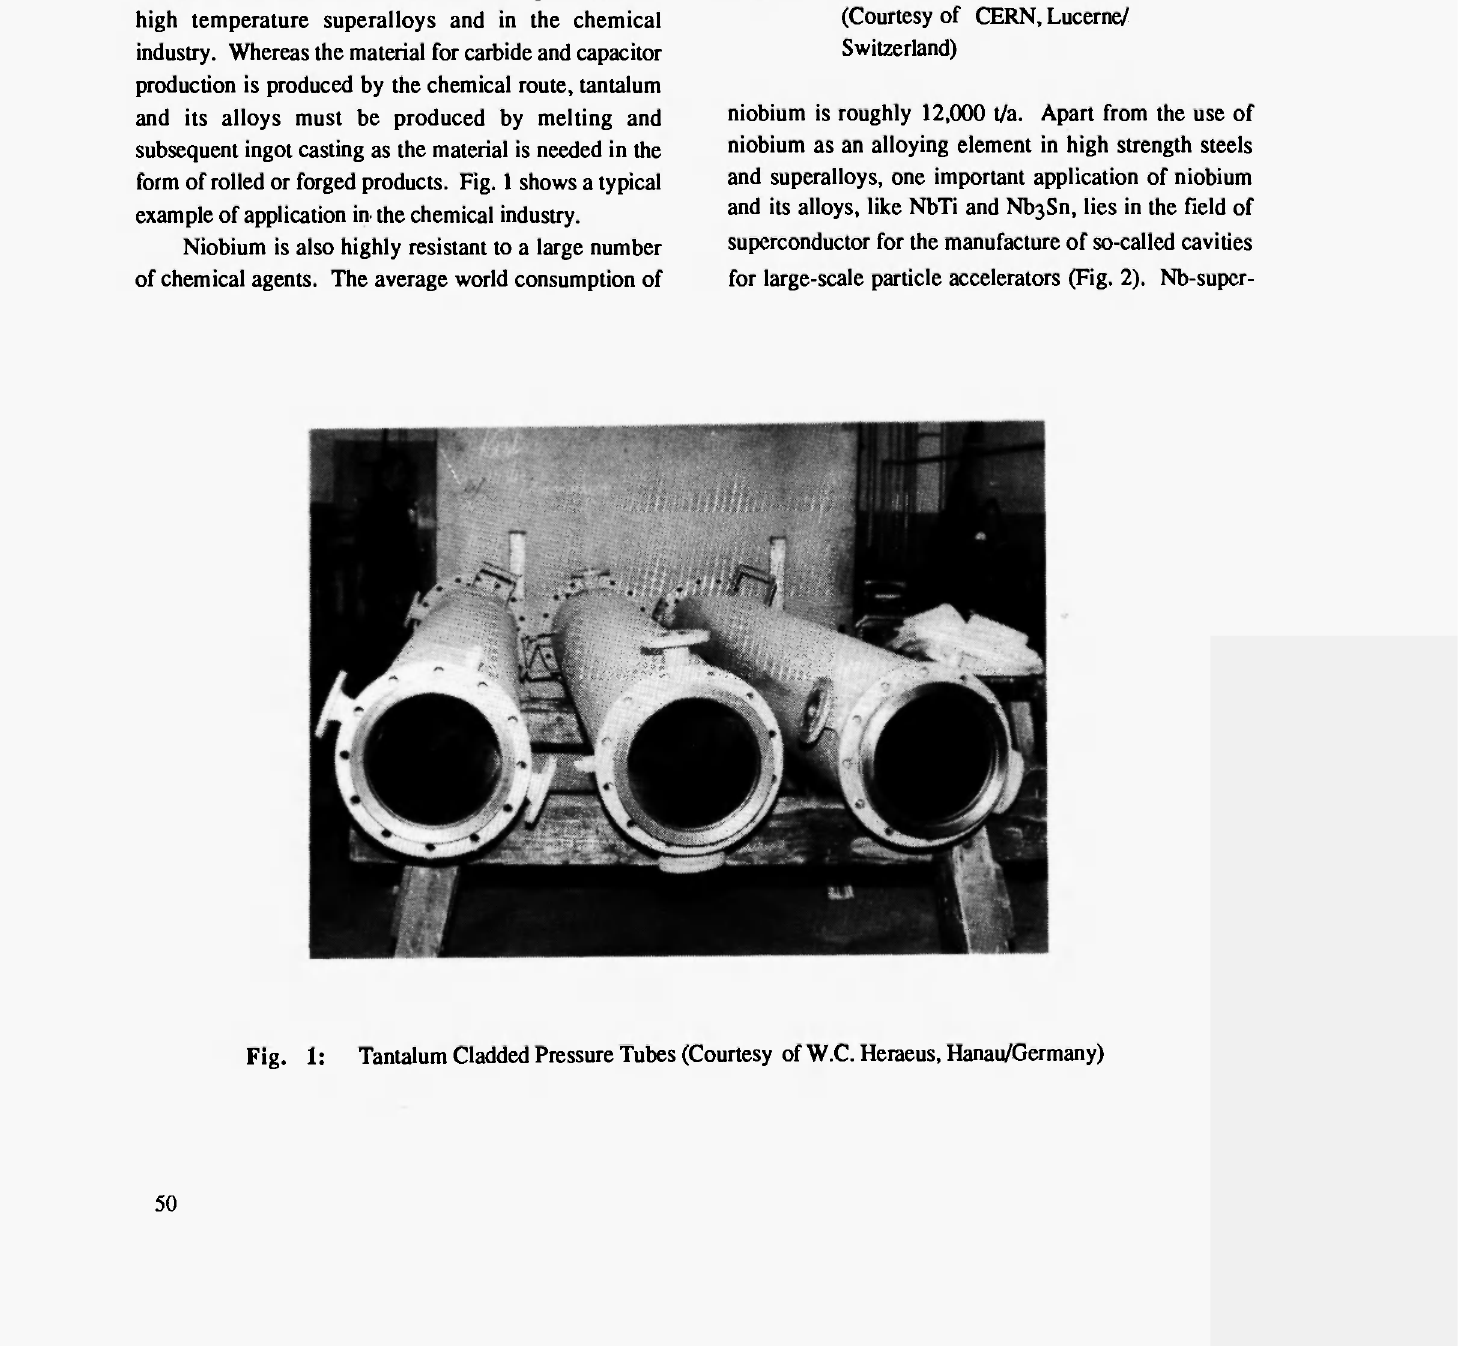
Fig. 2: Four-Cell Nb-Cavity Structure (Courtesy of CERN, Lucerne/ Switzerland) niobium is roughly 12,000 t/a. Apart from the use of niobium as an alloying element in high strength steels and superalloys, one important application of niobium and its alloys, like NbTi and Nb3Sn, lies in the field of superconductor for the manufacture of so-called cavities for large-scale particle accelerators (Fig. 2). Nb-supcr-